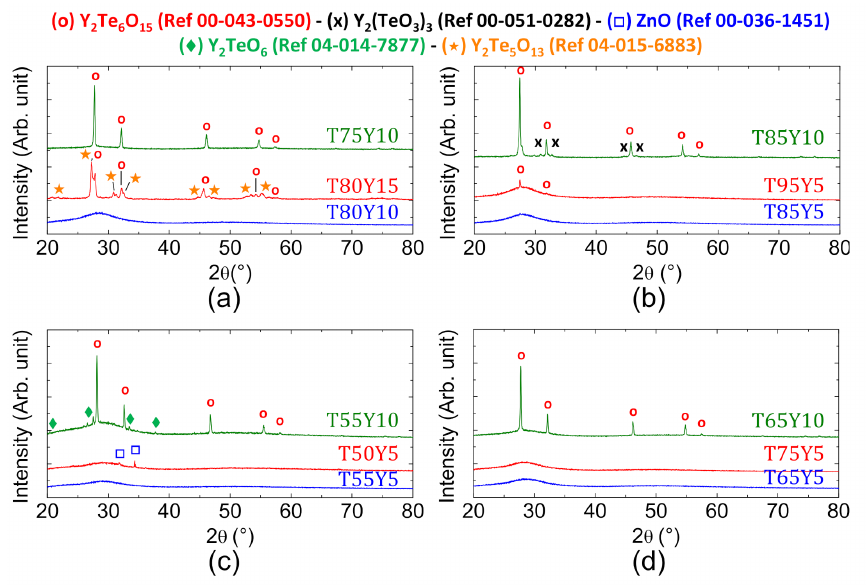
Figure 2. X-ray diffraction diagrams of ( a ) the T75Y10, T80Y15 and T80Y10 samples; ( b ) the T85Y10, T95Y5 and T85Y5 samples; ( c ) the T55Y10, T50Y5 and T55Y5 samples and ( d ) the T65Y10, T75Y5 and T65Y5